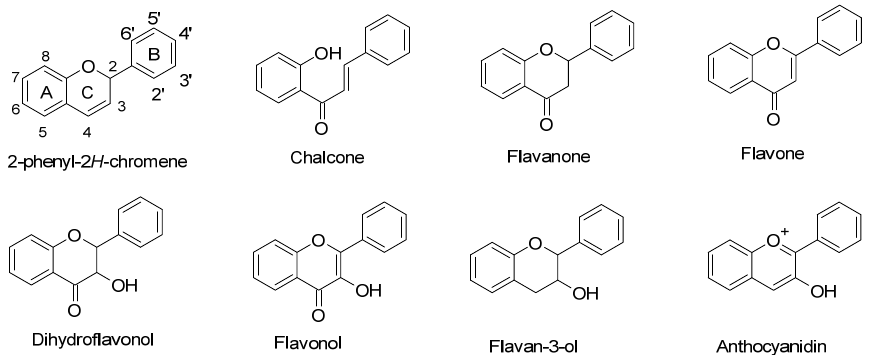
Figure 1. Chemical structure of flavonoid subgroups and the basic C6-C3-C6 skeleton (2-phenyl-2 H - chromene). A, B, and C refer to a specific ring of the flavonoid skeleton.